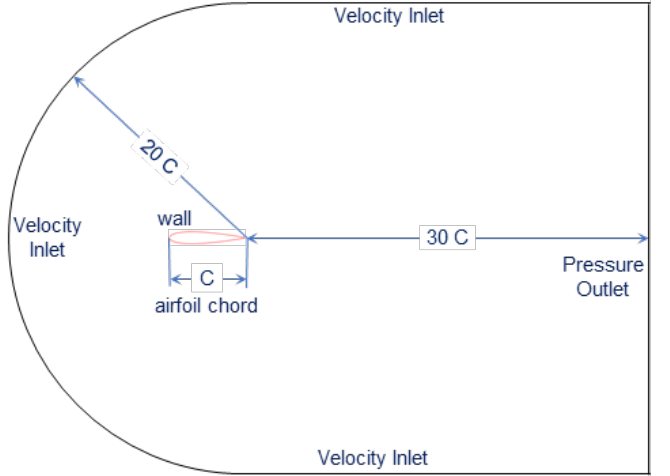
Figure 3. C-type geometry of control domain with the recommended dimensions for ice accretion modeling around a symmetric airfoil—the airfoil size is exaggerated for clarity. @Fahed Martini.